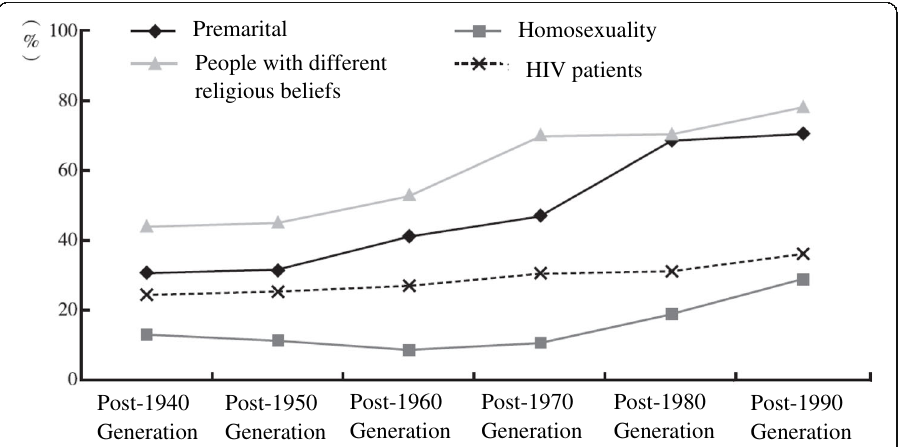
Fig. 4 Generational disparities in social tolerance: acceptance of certain behaviors and